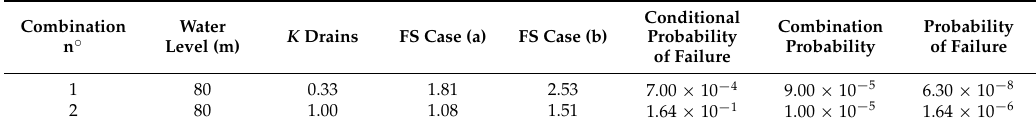
Table 16. Approach III. Results for SOF = 20